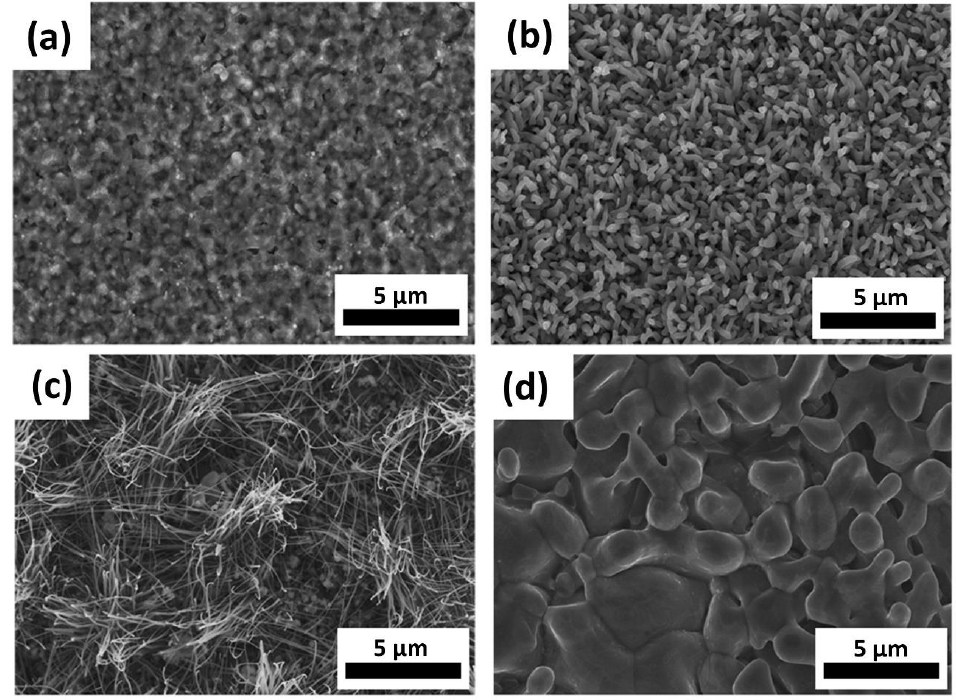
Figure 2. SEM images of samples grown at ( a ) 650 °C, ( b ) 750 °C, ( c ) 850 °C, and ( d ) 1000 °C at 3 × 10 −1 torr for 2 h.